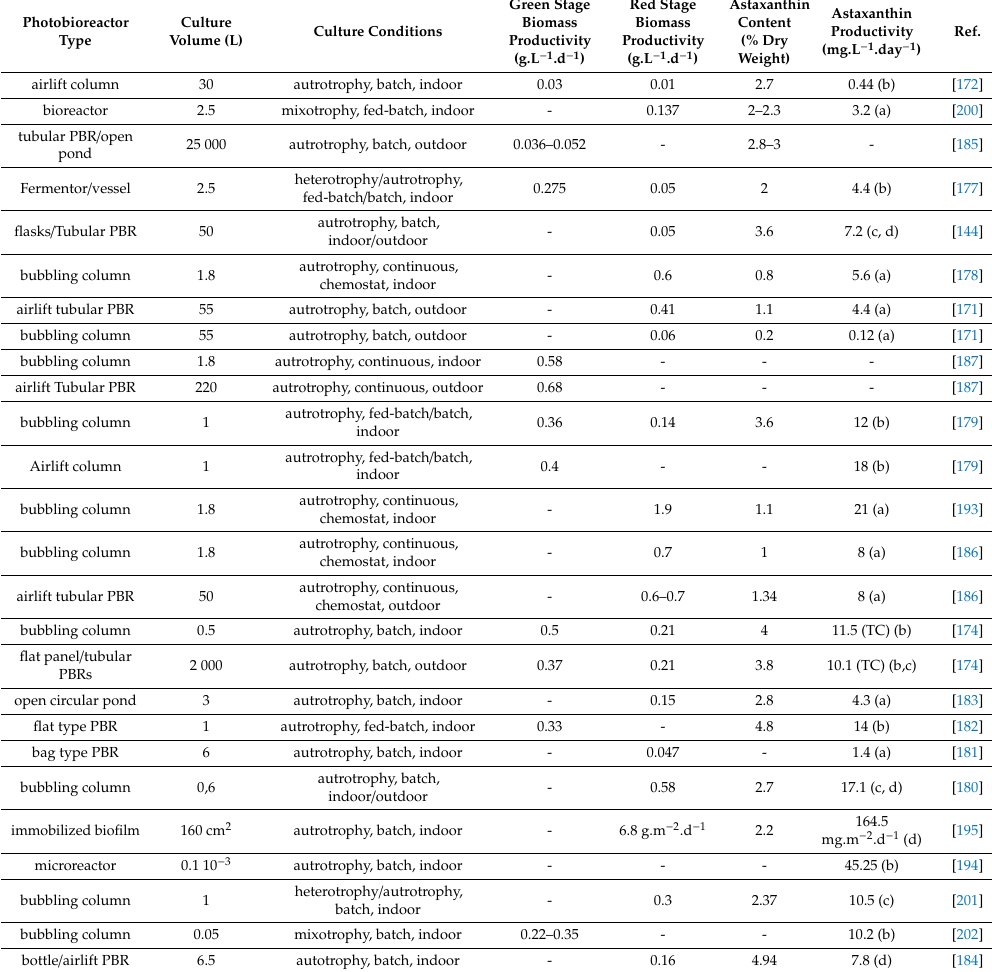
Table 3. Cultivation of H. pluvialis in various types of photobioreactors and